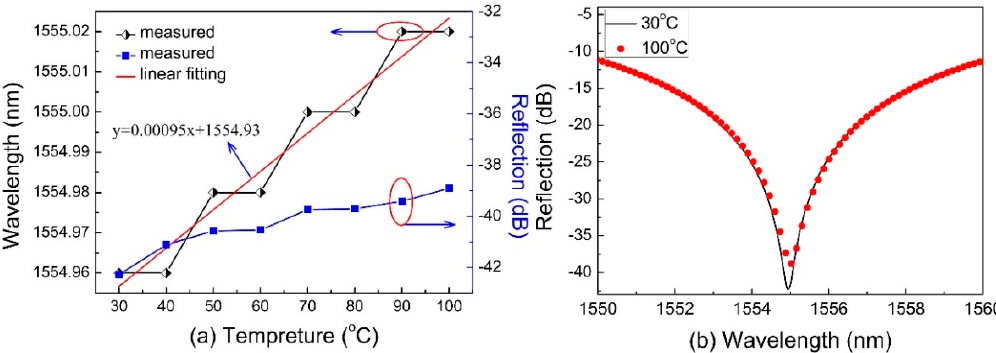
Figure 5. ( a ) Linear relationship between the wavelength shift of the interference dip at ~1555 nm and ambient temperature. ( b ) The reflection spectra of FPI at 30 ℃ and 100 ℃ .